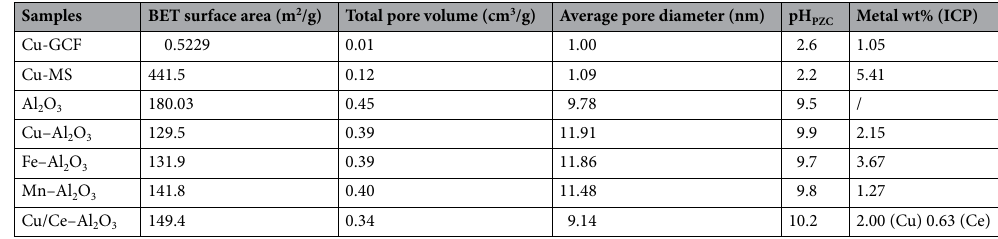
Table 1. Physical properties of the